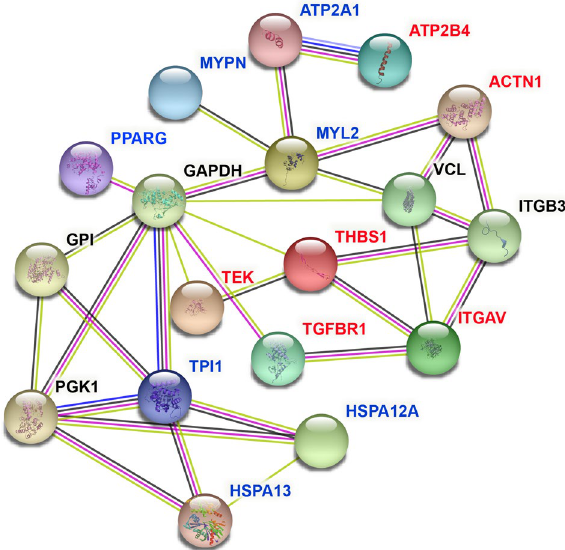
Figure 4. PPI network of the candidate genes affecting the WHC. The novel potential candidate genes influencing WHC found in this experiment are marked in red, while genes marked in blue represent they have been confirmed by predecessors to be related to